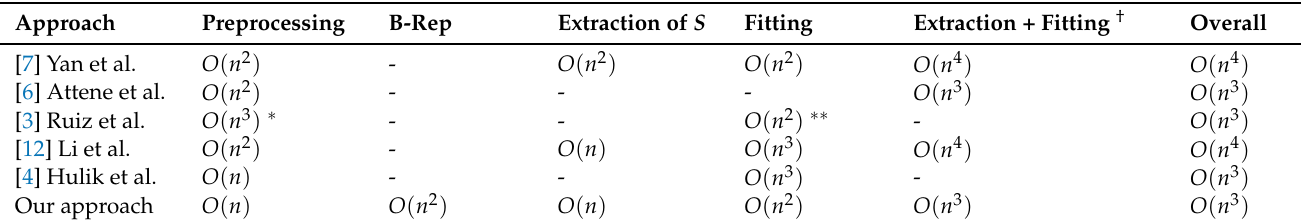
Table 10. Complexities of existing approaches and of our algorithm ( n is the number of points or triangles of the input set). ∗ Obtaining initial guess of g () . ∗∗ Applying optimization to g () . † Segmentation and fitting are codependent.